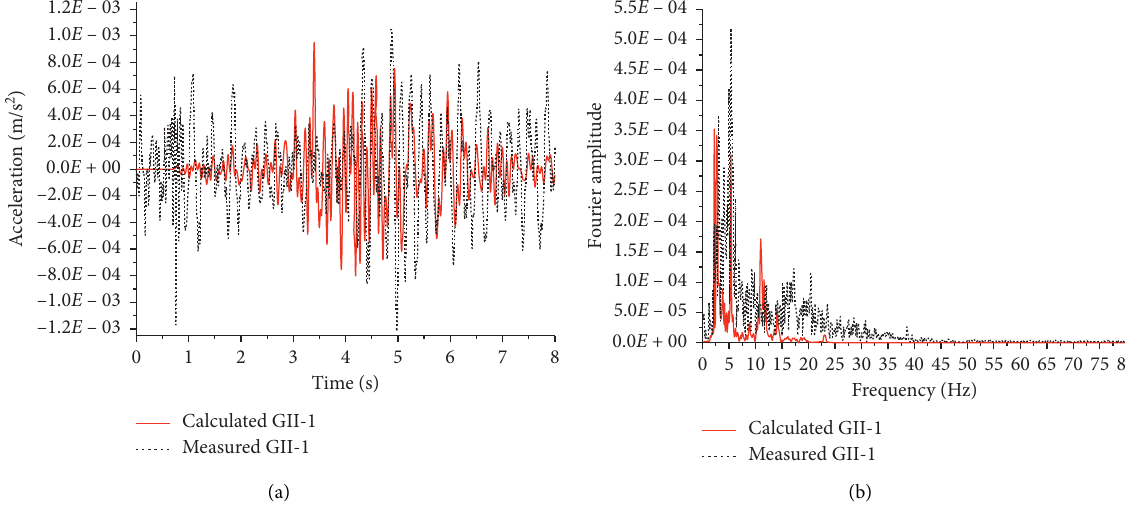
Figure 24: Comparison of numerical and field results (GII-1): (a) acceleration time history; (b) frequency spectrum.